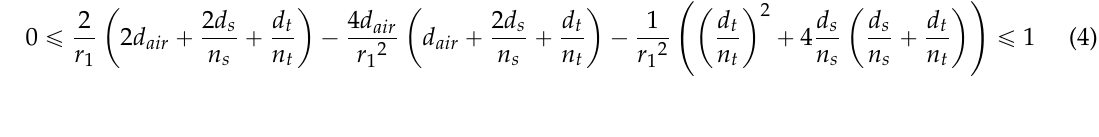
Figure 3. Schematic diagram for: ( a ) the horizontal cross section and ( b ) the vertical cross section, of the cylindrical Fabry-Pérot cavity with the micro tube inside indicating the design parameters and geometry.